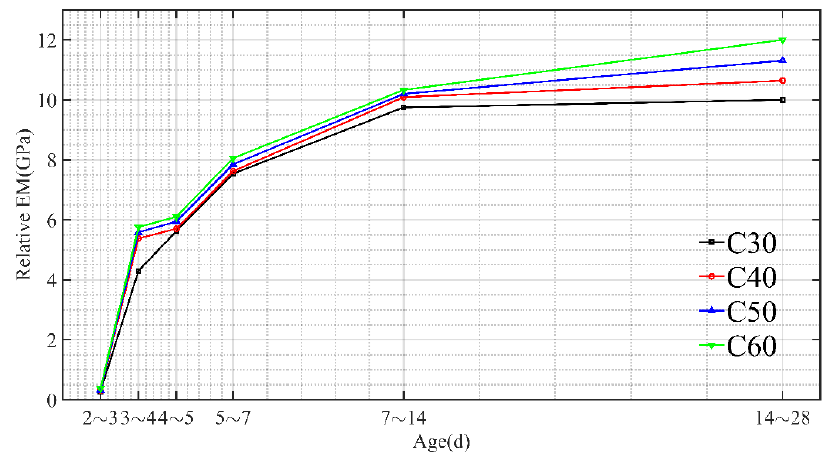
Figure 7. Fitting curve of elastic modulus of a micro-matrix around the capillary ( 𝐸 𝑡 ) and static elastic modulus ( 𝐸 𝑐 ).